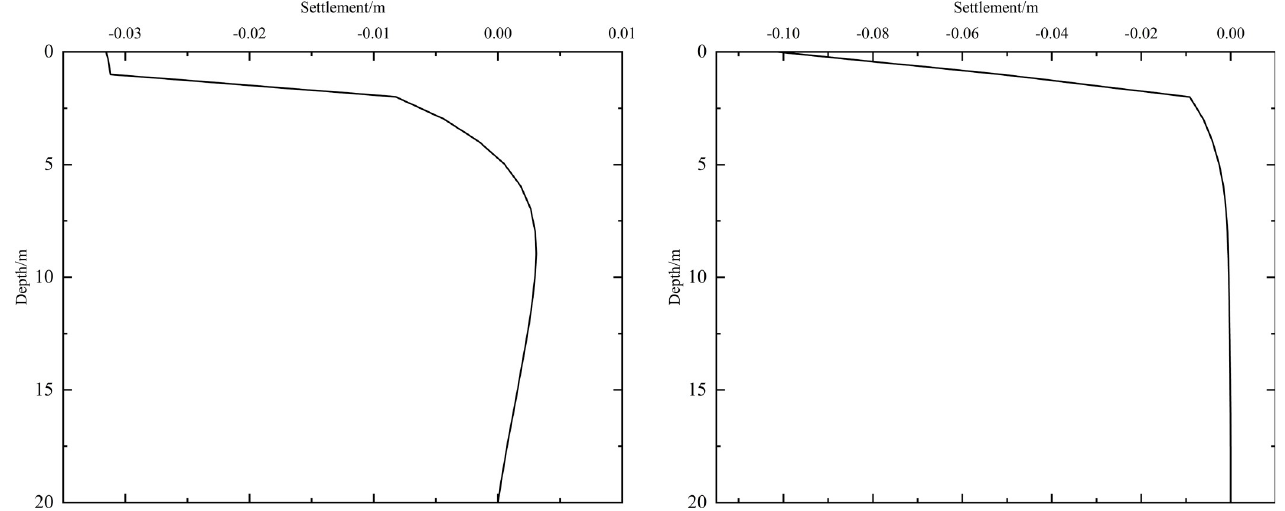
Fig 12. Settlement-depth curves after 10 years of operation at the (a) pavement center and (b) natural surface center.